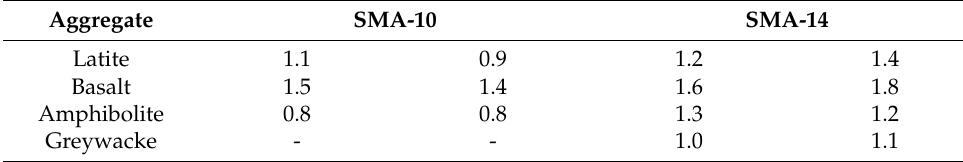
Table 12. Binder drain down results. Table 11. Surface texture results (duplicate) (mm).